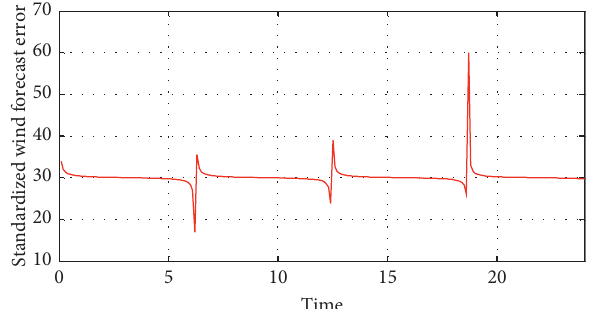
Figure 8: Wind forecast error with standardized mean square